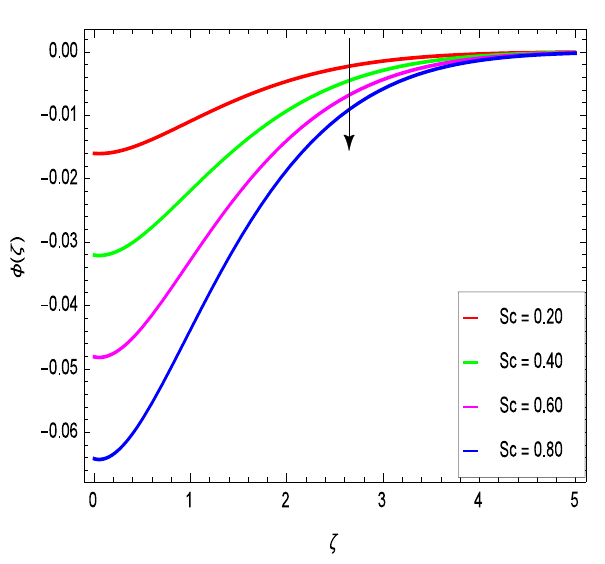
Figure 17. φ(ζ) in terms of Sc